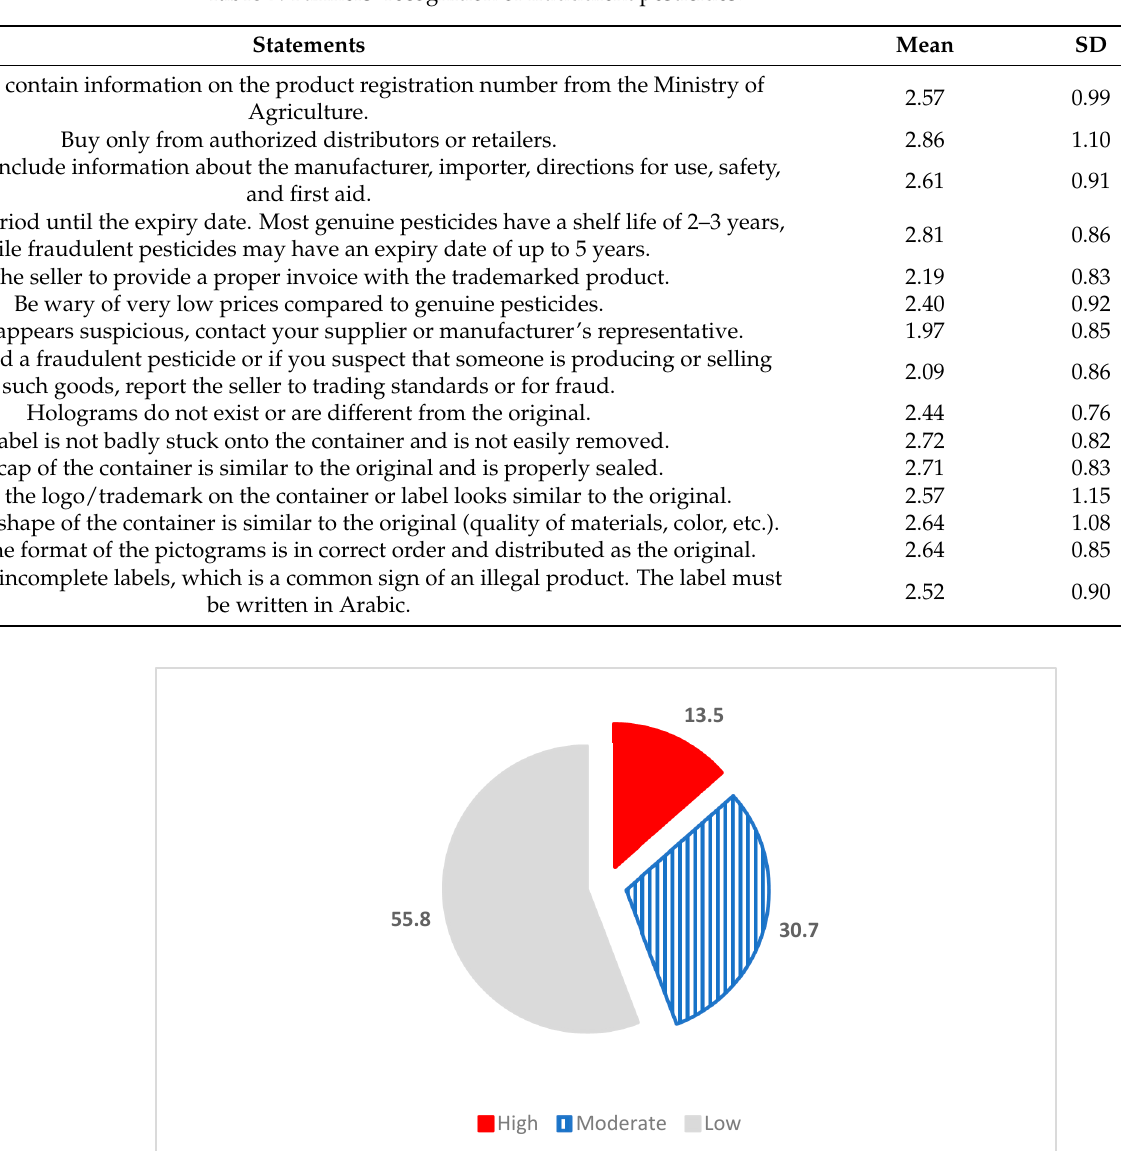
Table 7. Farmers’ recognition of fraudulent pesticides.